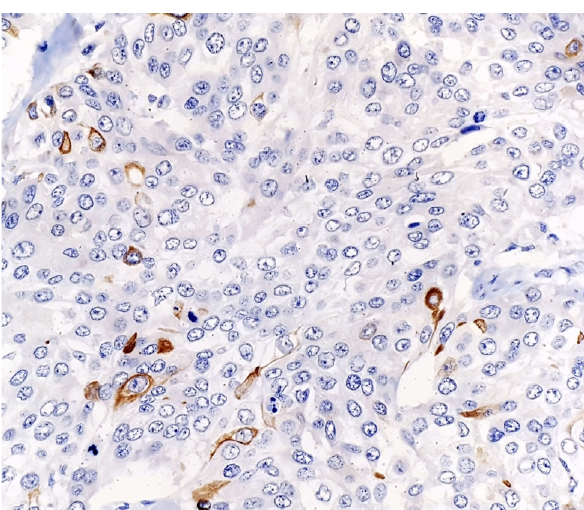
Fig. 1. Focal positivity of CD133 in high-grade urothelial carci- noma (magnification x400).